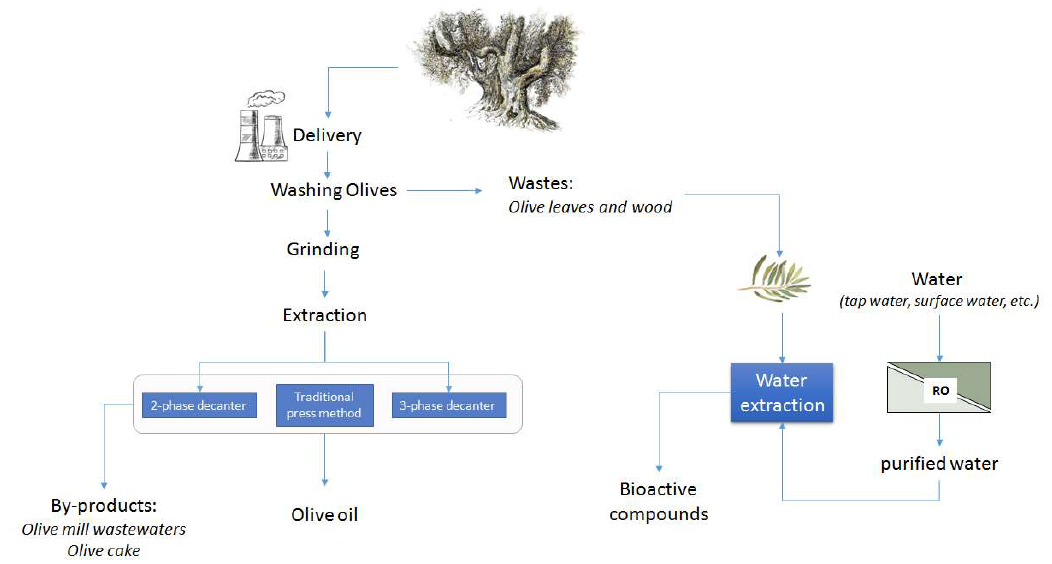
Figure 4. Scheme of olive oil production and aqueous extracts of highly nutritional and pharmacological value from olive leaves (RO, reverse osmosis).